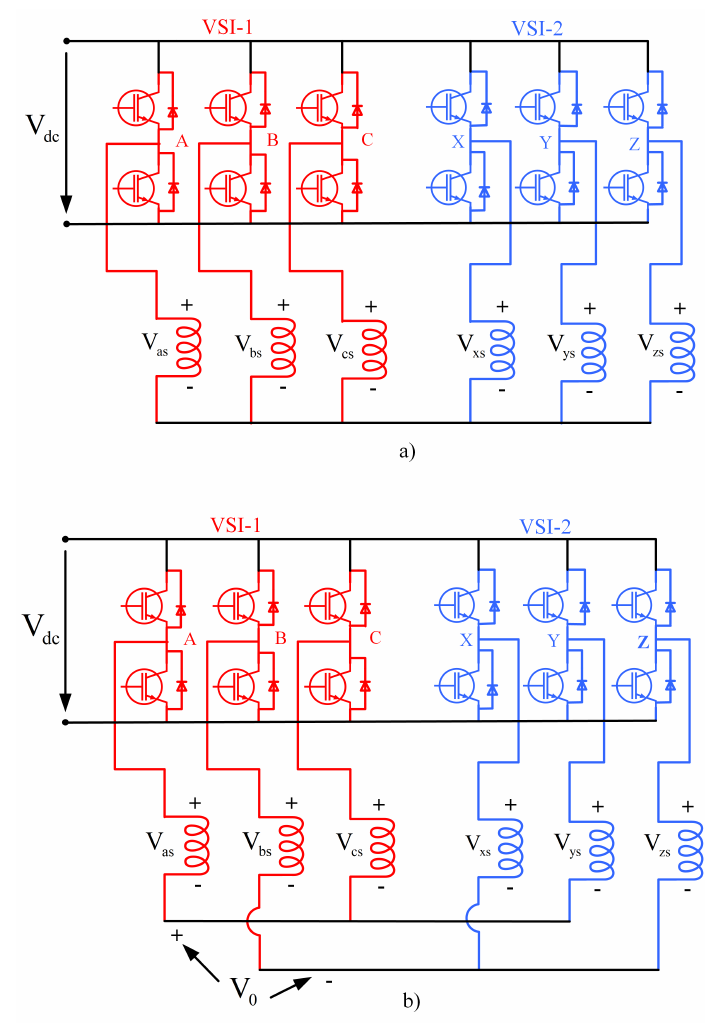
Figure 2. Voltage source inverter-fed DTP-PMSM drive with stator winding connection. ( a ) single neutral topology; ( b ) two isolated neutrals topology